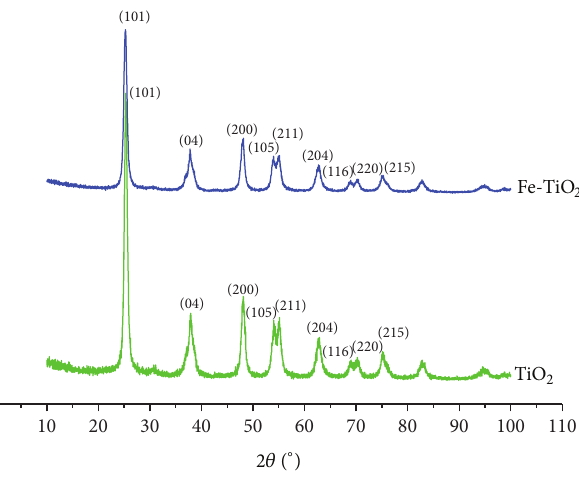
Figure 1: XRD spectra of TiO 2